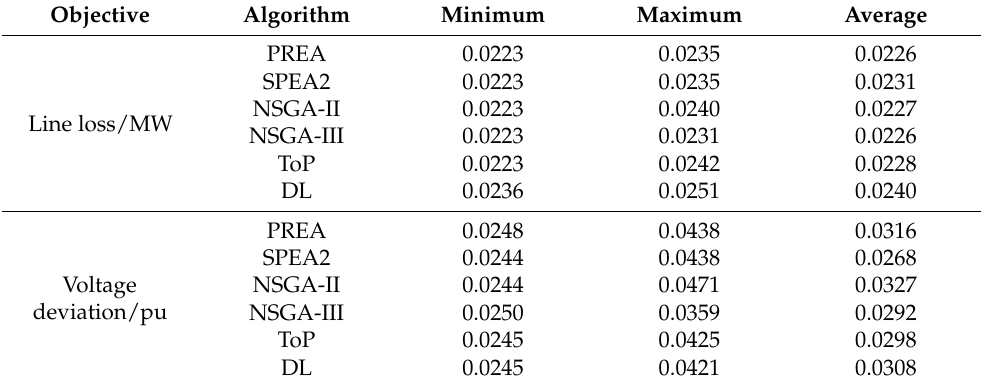
Table 3. Statistical results of PFs obtained in the IEEE 14-bus system.